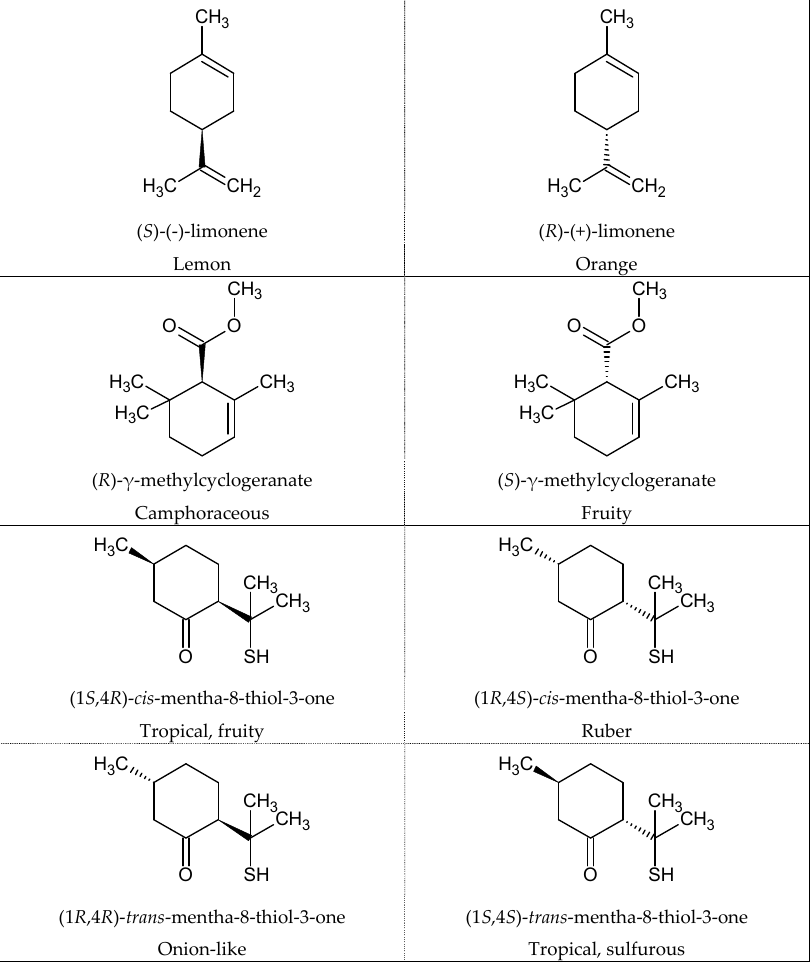
Figure 3. Examples of enantiomeric compounds with dissimilar odors [31,33].